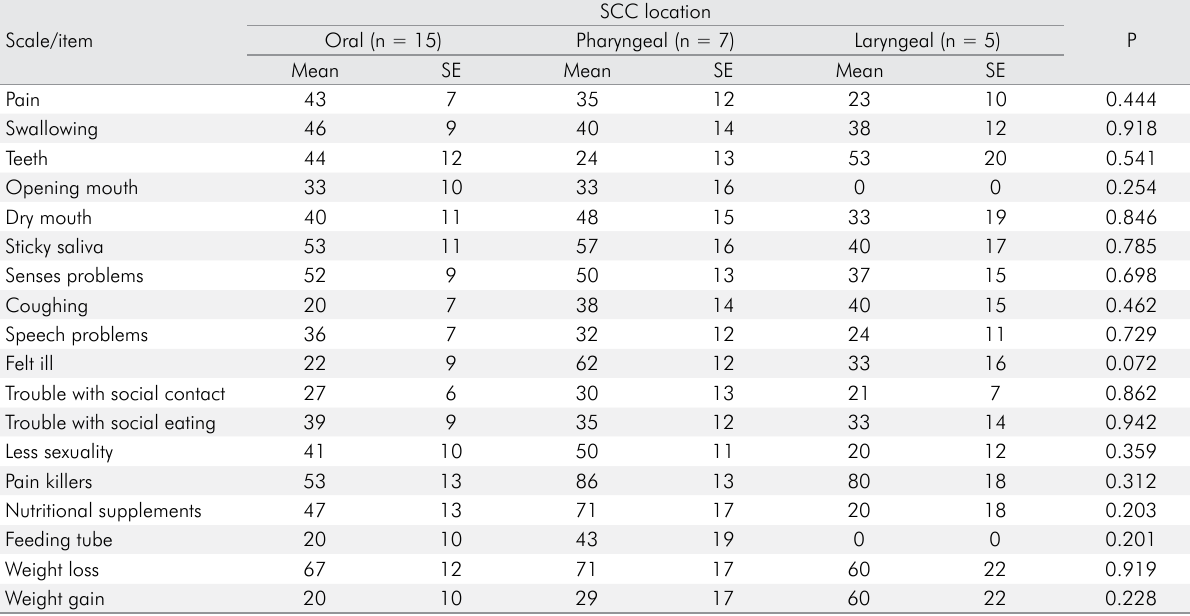
Table 2. QLQ-HN35 scores according to tumor location.